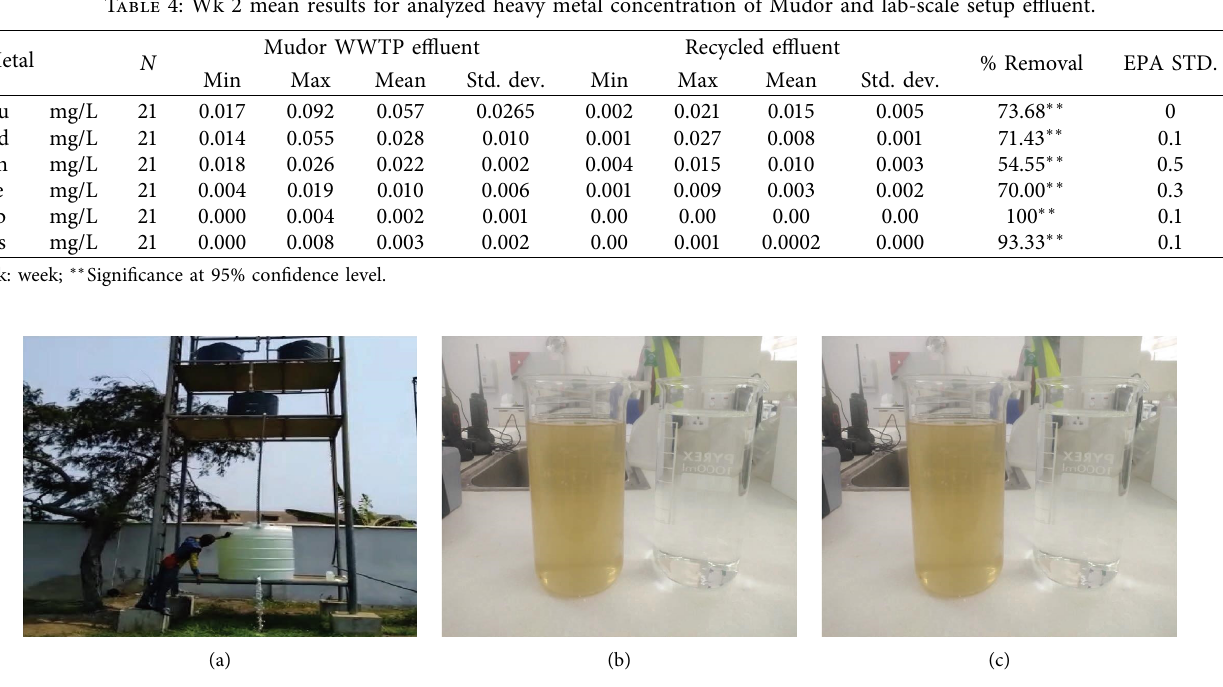
Figure 4: (a) DFSAC fltration setup. (b) Efuent from Mudor WWTP. (c) Efuent from DFSAC fltration